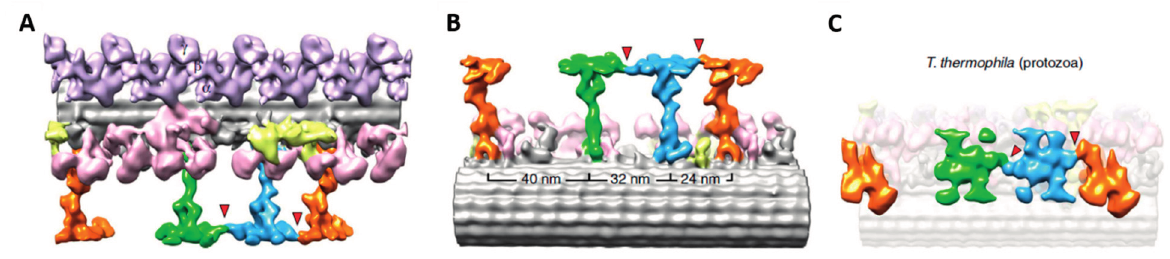
Figure 4. Tomogram from a Tetrahymena cilium. Isosurface renderings show the averaged 96-nm axonemal repeats of the Radial Spoke proteins. Radial spoke proteins 1, 2, and 3 are shown in green, blue, and orange, respectively. The ODA are shaded in purple, IDA are shaded in light pink, and yellow shading indicates the Nexin-Dynein Regulatory Complex. The red arrowheads indicate the connections between the radial spokes. ( A ) is a longitudinal- front view, ( B ) longitudinal back view, and ( C ) a bottom view. Adapted from [28], with